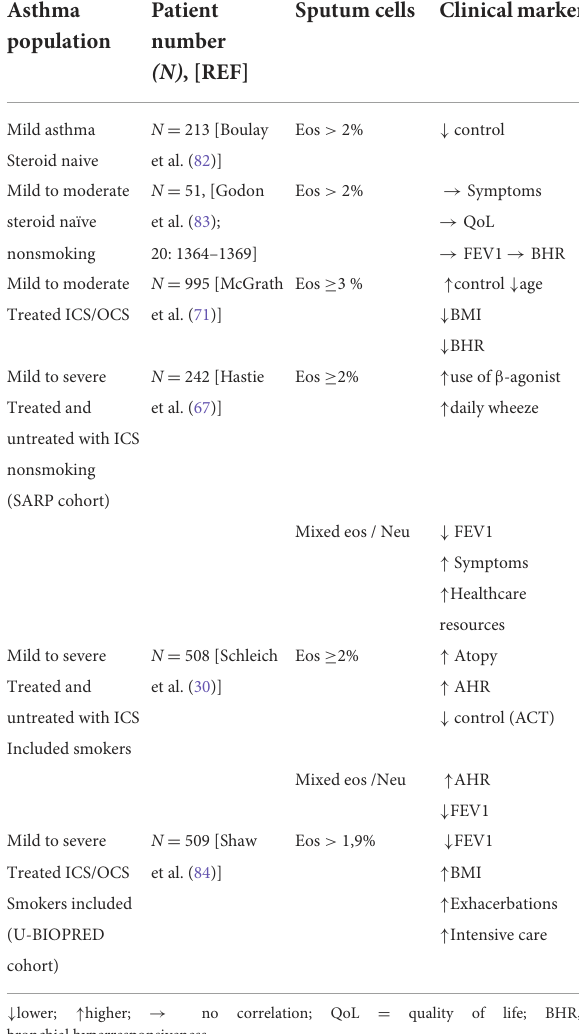
TABLE 5 Associations between sputum inflammatory phenotypes and clinical